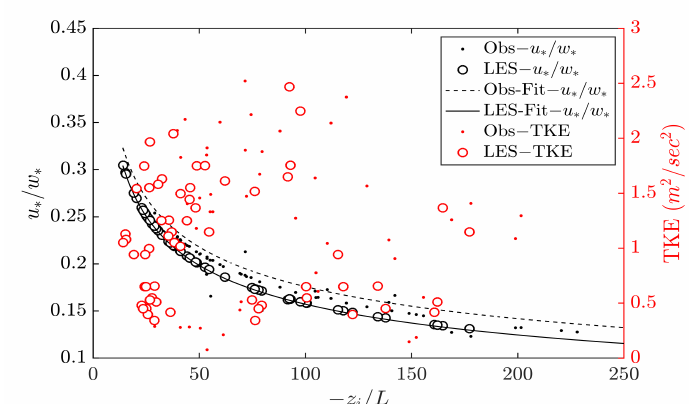
Figure 12. Ratio of friction velocity and convective velocity (left axis, black) and TKE (right axis, red) plotted against the stability parameter for all IOPs simulated. Solid dots indicate observed values of (black) and (red). White circles indicate LES simulated (black) and TKE (red). Dashed line is the power law fit between and observed, solid line is the power law fit from LES